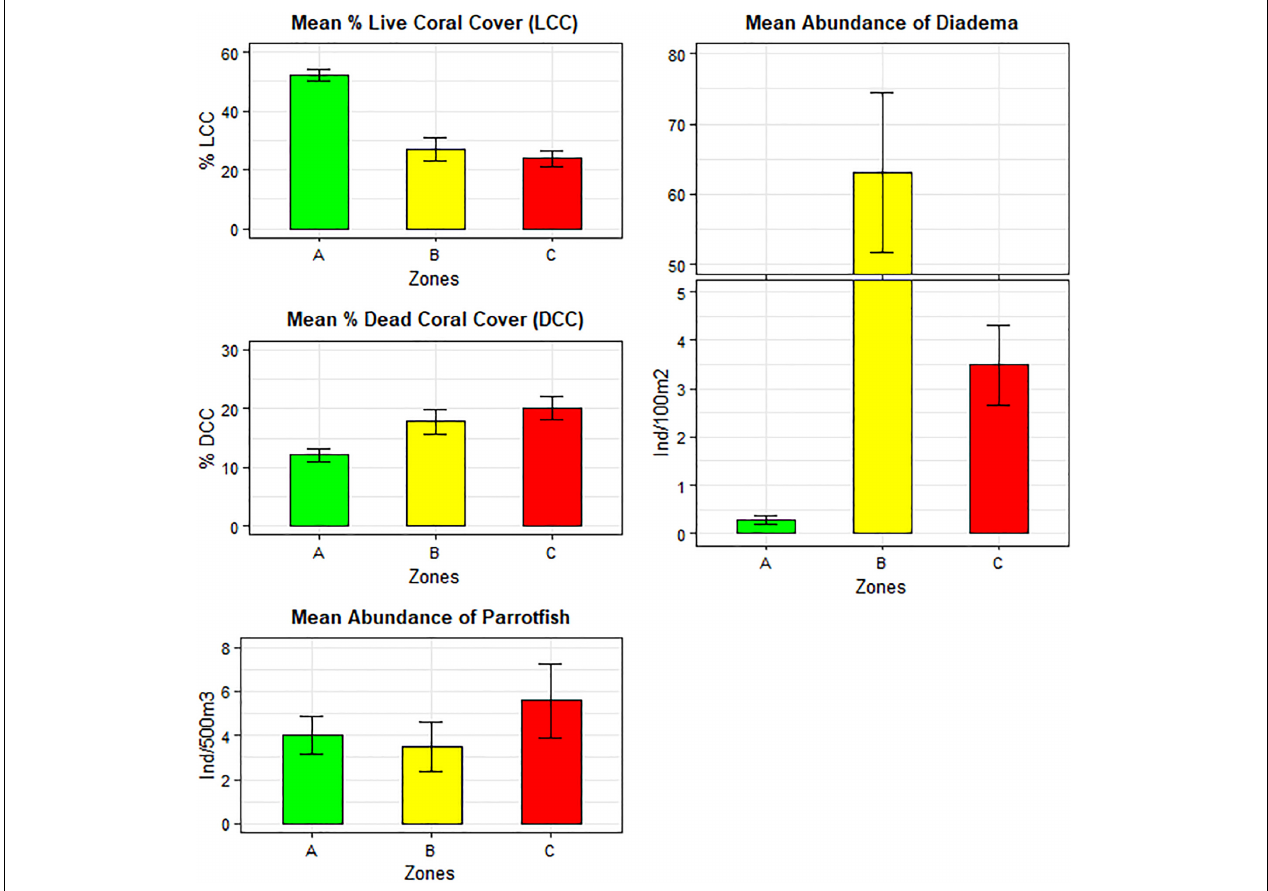
FIGURE 3 | The percentage coverage (mean ± SE) of Live and Dead Coral Cover (% cover), and abundance (mean ± SE) of Parrotfish (individual/500 m 3 ) and Diadema (Long-spined Sea Urchin) (individual/100 m 2 ) in the three respective zones (A, B, and C) determined in this